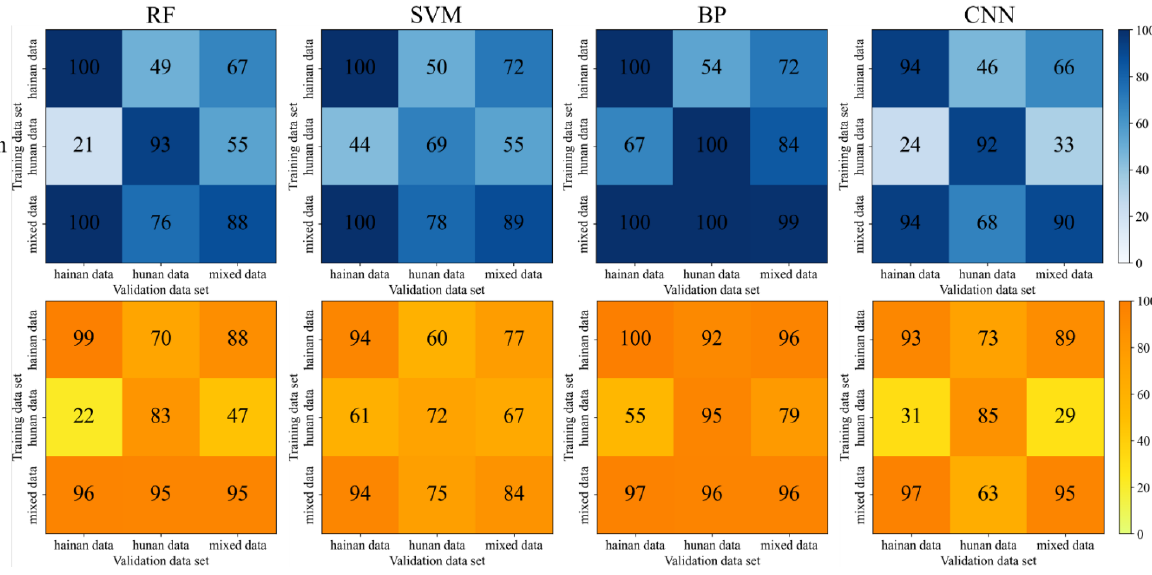
Figure 9. Evaluation results of each algorithm after feature extraction with PCA algorithm.